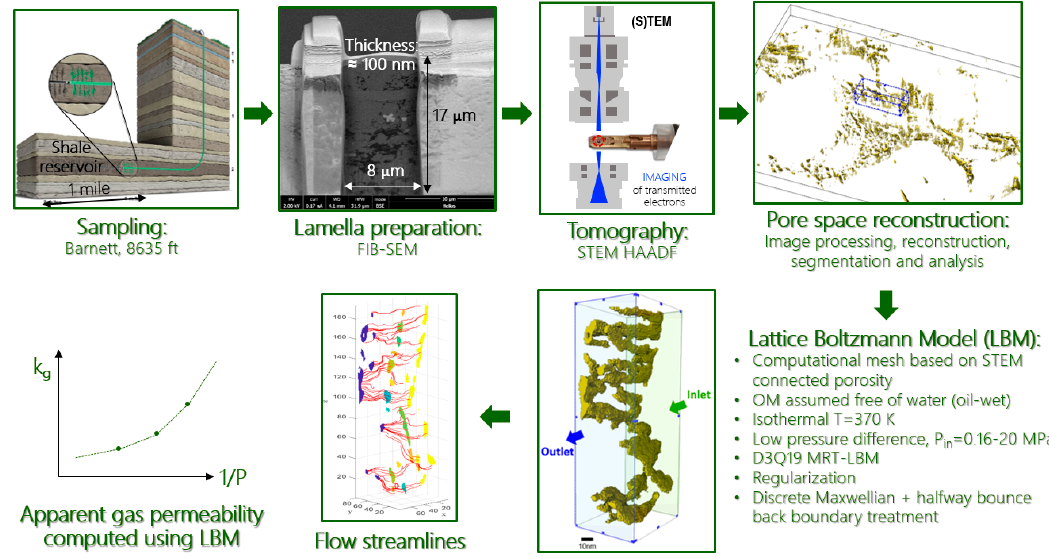
Figure 1. Workflow from sample acquisition to preparation to STEM tomography to transport